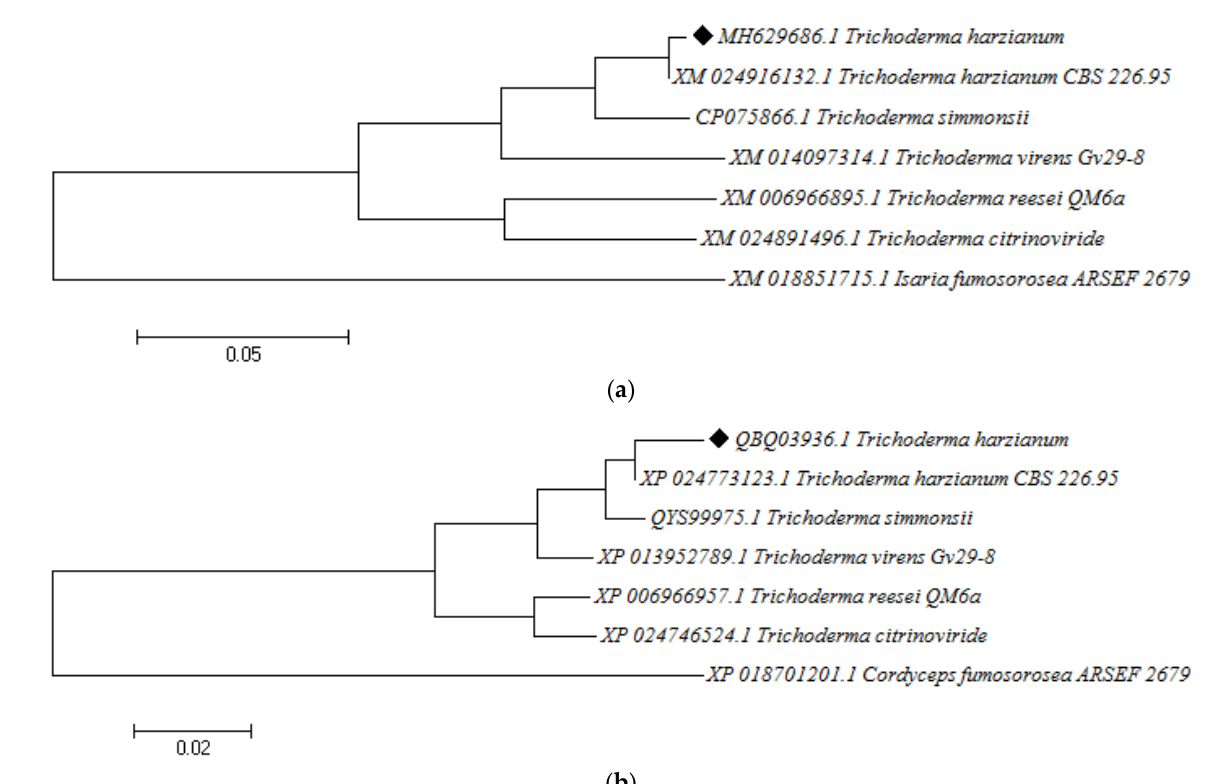
Figure 4. The percentage of identity in the cyanide hydratase of indigenous T. harzianum and four Trichoderma species and their catalytic triads, using ( a ) ClustalW and ( b ) Jalview.